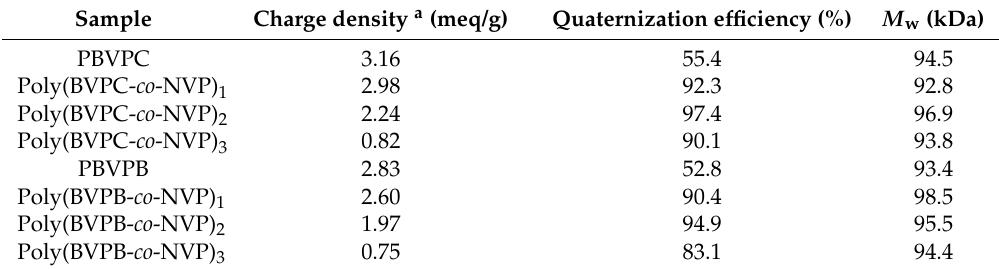
Table 2. Charge density, quaternization efficiency and molecular weight of quaternary pyridinium- type copolymers. pyridinium-type